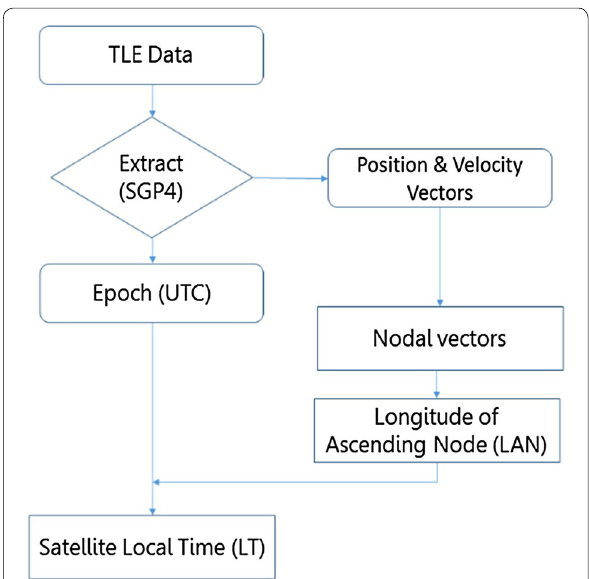
Fig. 6 Procedure for LEO satellite local time